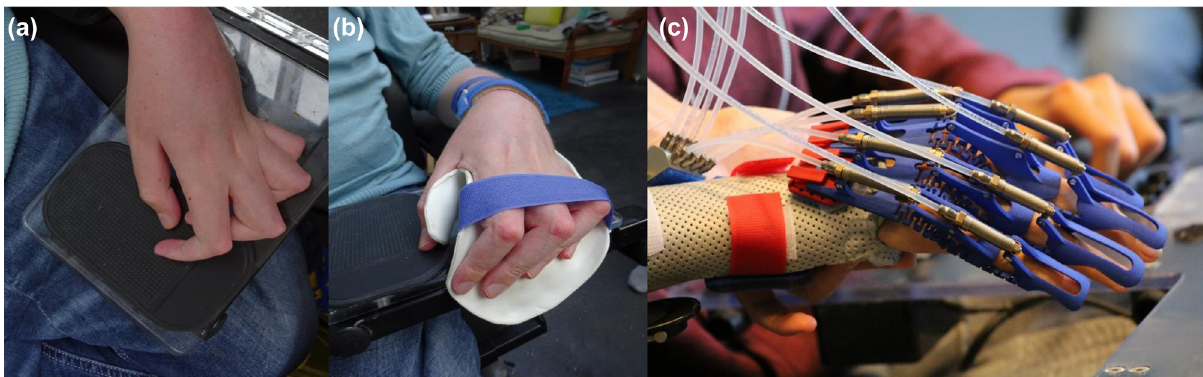
Figure 1: ( a ) The typical hand of a nonambulatory person with DMD. There are already obvious joint contractures that create a bear claw shape for the hand. ( b ) A resting hand splint used commonly by people with DMD to preserve larger range of motion for the fi ngers and prevent contractures. ( c ) A novel active wearable robotic exoskeleton for people with DMD ( SymbiHand [ 16,17